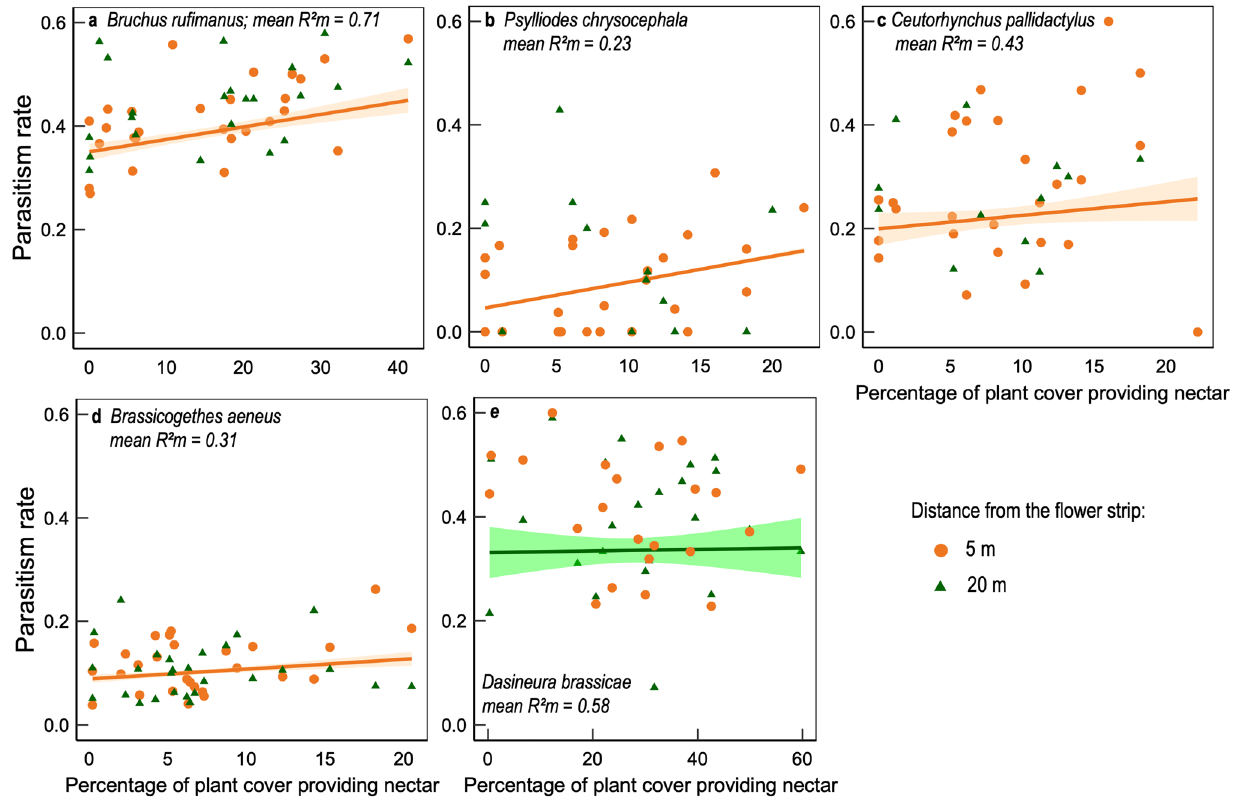
Figure 3. Effect of the percentage of the plant cover providing accessible nectar to parasitoids on parasitism rates in five crop herbivores (mean prediction and 95% confidence intervals). Partial regression plots result from a generalized mixed model, assuming the errors to be binomially distributed. Parasitism rates were measured at 5 m (orange circles) and 20 m (green triangles) from the flower strip. Regressions are shown only when a significant effect nectar resources, is found. The R 2 are the mean values for the best models detailed in Table S8. This figure was made using R version 3.6.3 30 (https:// www.R- proje ct.